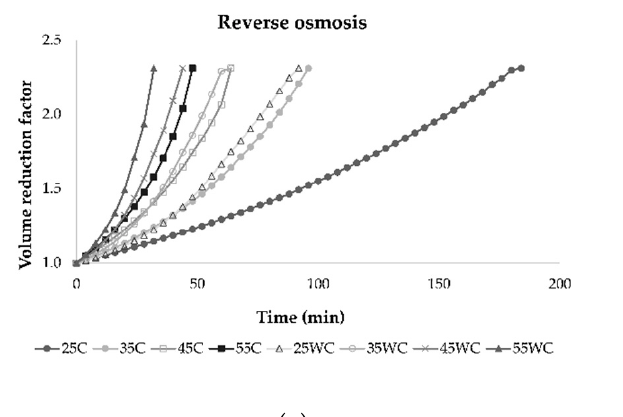
7 of 17 Figure 2. Influence of retentate concentration index (I